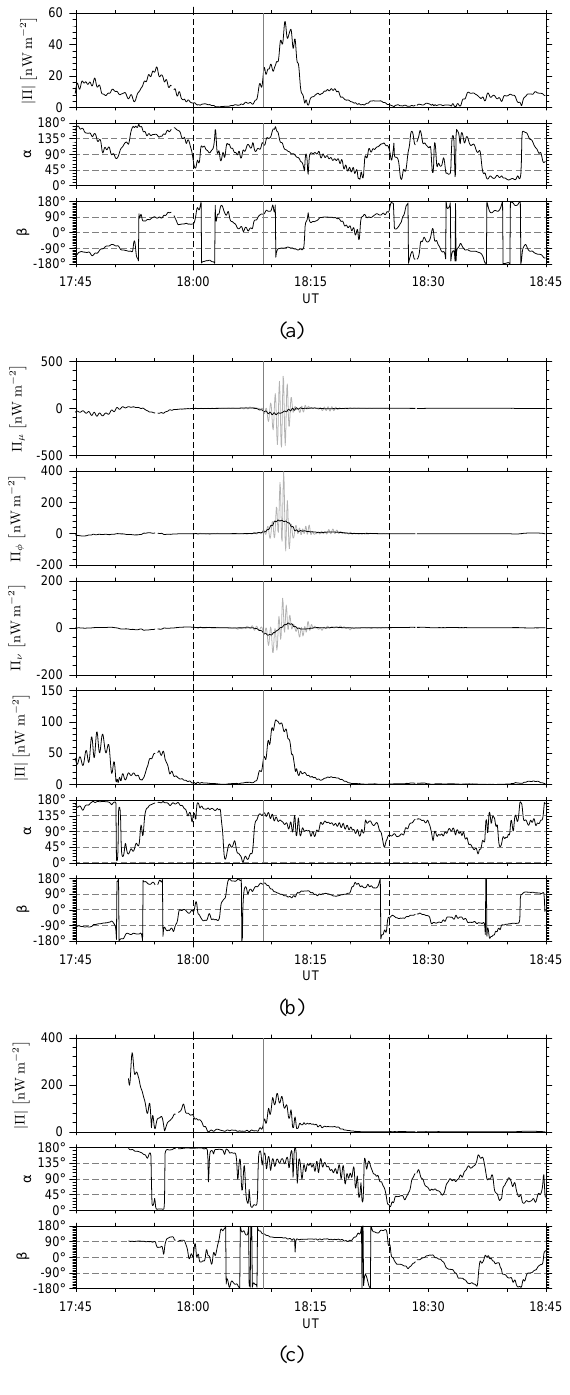
Fig. 11: Poynting flux at satellites (a) C1, (b) C2 and (c) Fig. 11. Poynting flux at satellites (a) C1, (b) C2 and (c) C4 dur- C4 during the event on 21 January 2003. In (b) each of ing the event on 21 January 2003. In (b) each of the components, the components, Π ν , Π φ and Π µ , is filtered over the Pi2 5 ν ,5 φ and 5 µ , is filtered over the Pi2 frequency range (grey frequency range (grey curve) and averaged over a 150 s curve) and averaged over a 150s window (black curve). The Poynt- window (black curve). The Poynting flux magnitude and ing flux magnitude and orientation angles reflect the 150s orientation angles reflect the 150 s average.